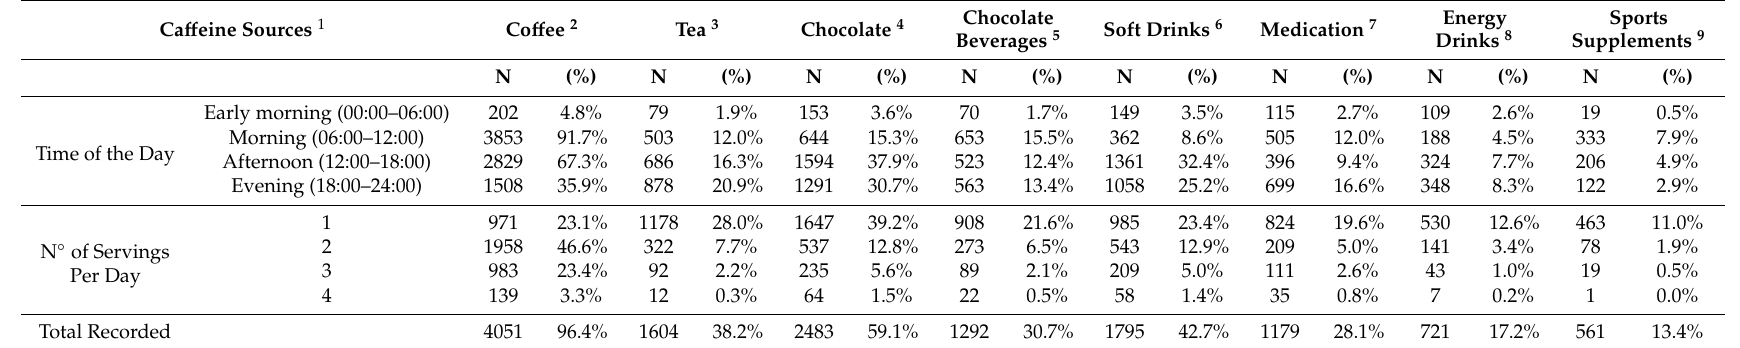
Table 3. Distribution frequency of regular consumption of sources of ca ff eine per week ( n =